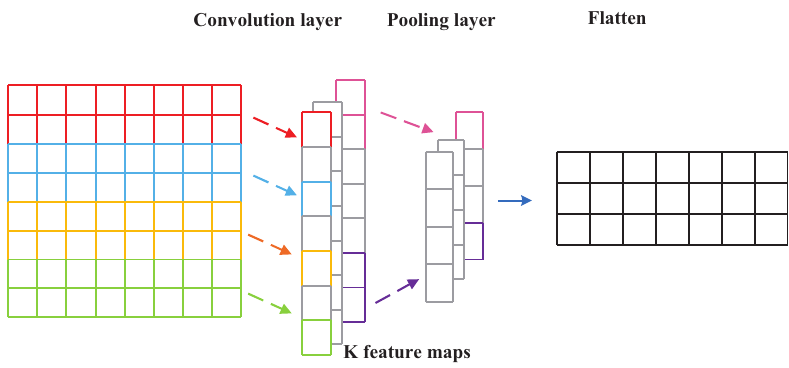
Figure 3. Convolutional neural network (CNN)